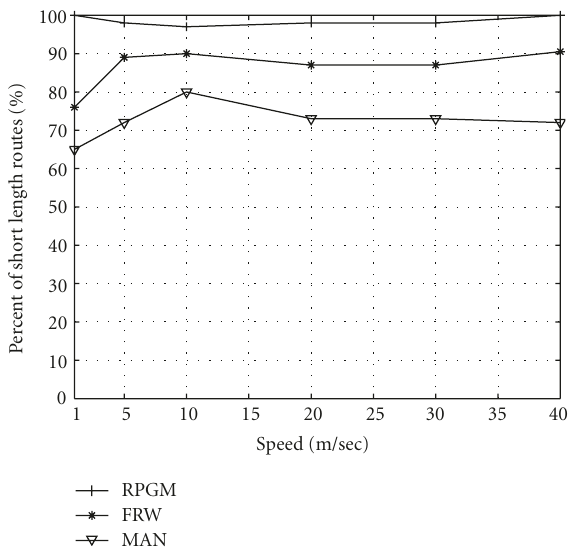
Figure 6: The percent of received TCP packets with short hop counts (hop count ≤ 3).